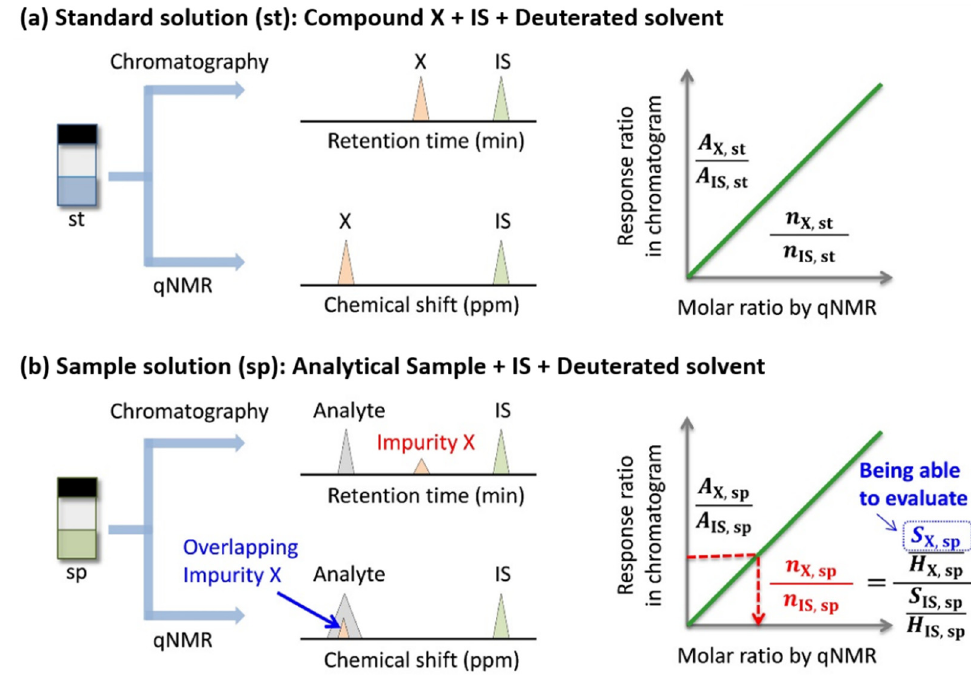
Figure 2. Schematic of the chromatography (EIC) procedure for ( a ) standard solution and ( b ) sample solution (Adapted with permission from [48], Elsevier, 2018).